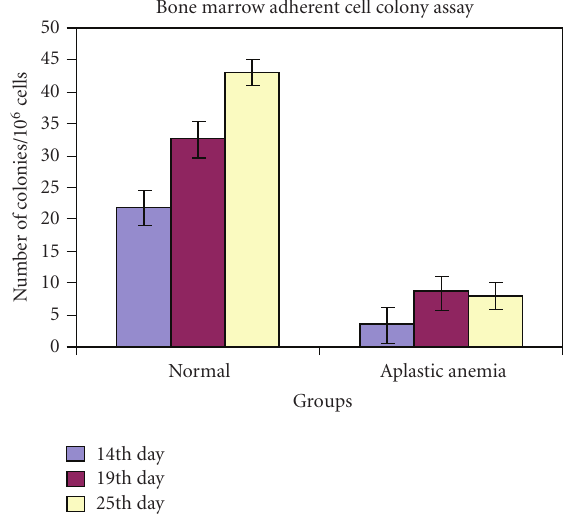
Figure 3: The quantitative distribution chart of the bone marrow adherent cell colony numbers at di ff erent day’s interval at 14th, 19th, and 25th days of culture from the normal and aplastic anemic groups of mice ( n = 15) showed an average decrease in adherent cell colony numbers in aplastic anemia through out the duration of culture compared to that of the normal ( n = 15) ( P < .